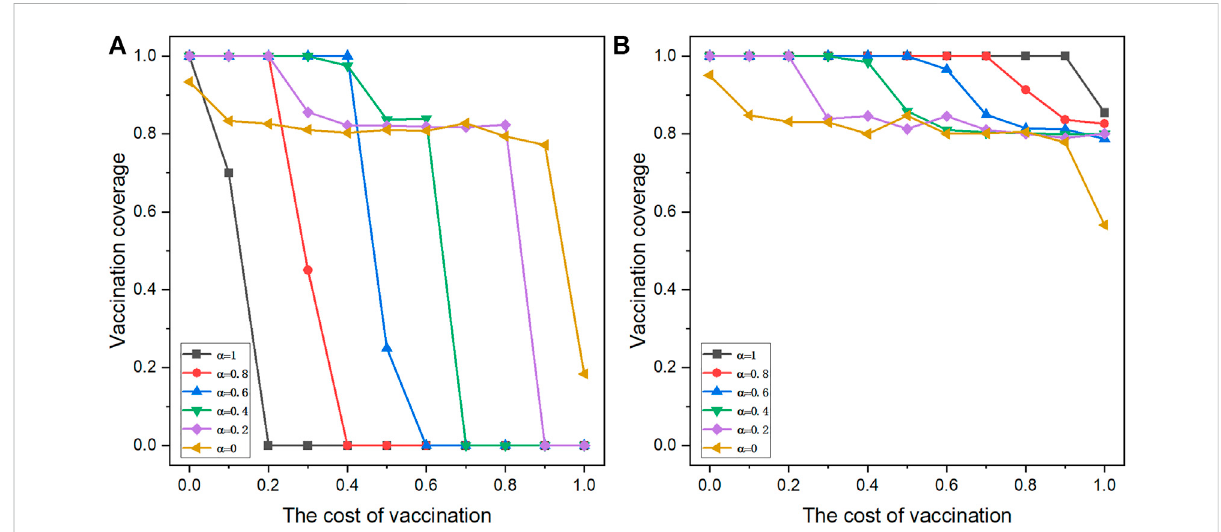
FIGURE 1 Vaccination coverage as a function of the relative cost of vaccination C V for V 0 = 0.2 (A) and V 0 = 0.6 (B) . Depicted results are obtained for γ = 0.8, K = 0.1, and C H = 1.